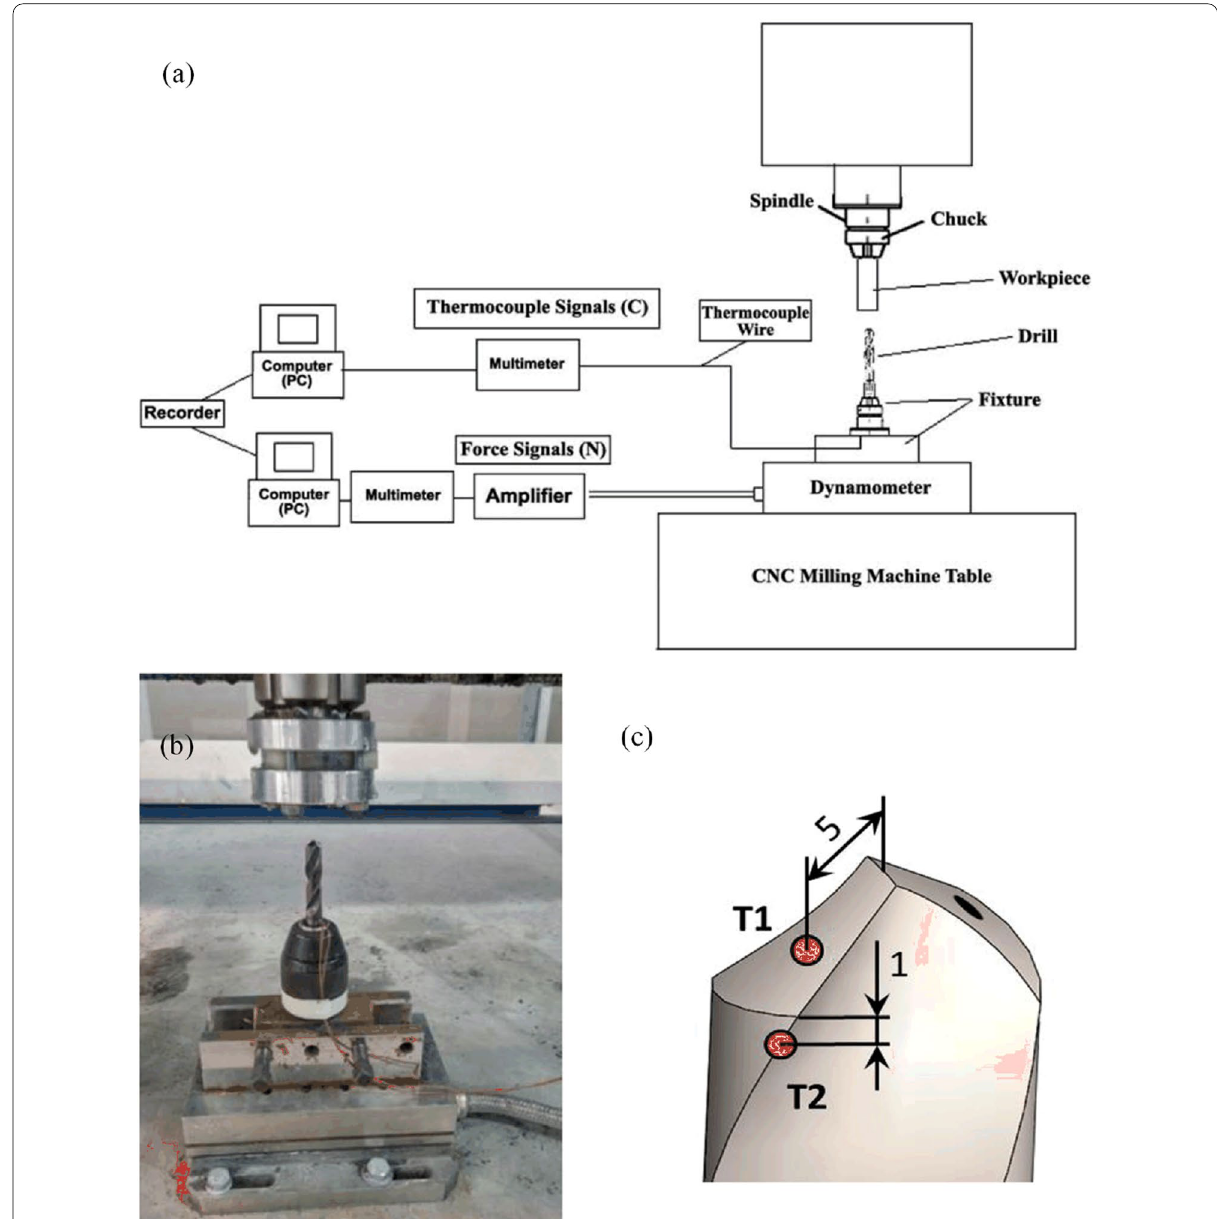
Figure 6 Thermocouple embedded in tool, a Schematic representation of experimental set-up, b The experimental set-up, c The thermocouple was inserted through the oil hole [32,